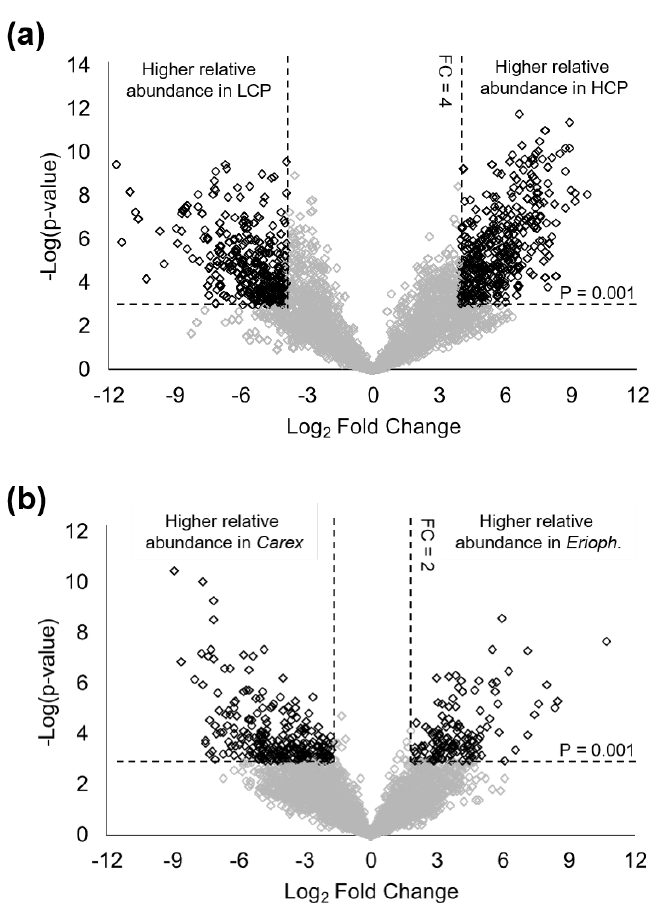
Figure 3. Volcano plots showing the differentially abundant LWM DOM features due to ( a ) polygon type or ( b ) vegetation, highlighting the features that had a fold change greater than 4 and passed the paired t -test p -value threshold of 0.001 (indicated by the dotted lines).